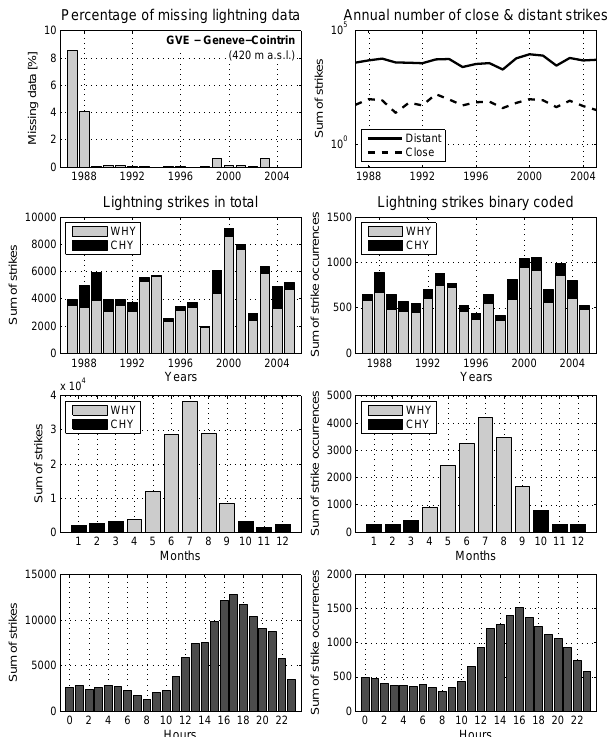
Fig. 4. Lightning data statistics for the station Geneve-Cointrin. Top left: percentage of missing (N/A) lightning data in each year. Top right: annual sums of close and distant lightning. The remaining fig- ures show the distribution of all the observed lightning (regardless whether close or distant) from an annual (row 2), seasonal (row 3) and daily (row 4) perspective. Left panels show the actual number of lightning strikes, right panels show the sums of the lightning oc- currence (binary per 10min interval). WHY (CHY) stands for warm (cold) half year. Time is in UTC, which is − 2h LT (summer) and − 1h LT